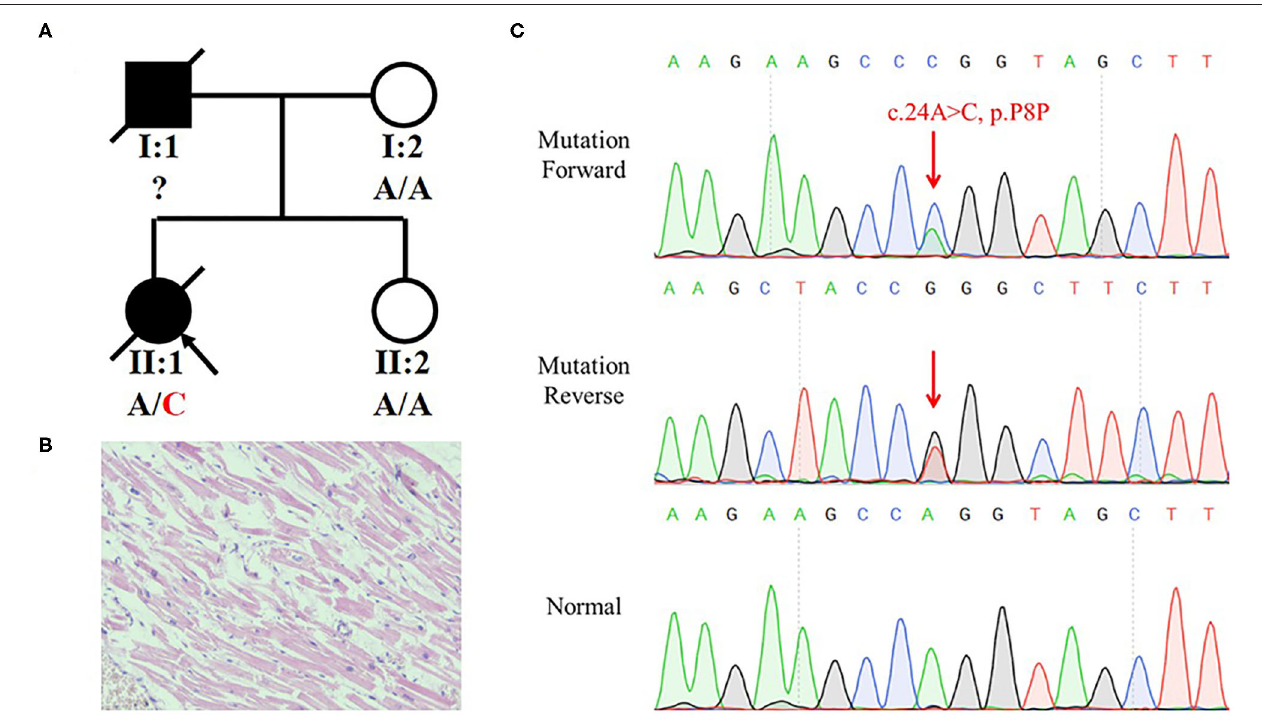
FIGURE 1 | Identification of a synonymous variant of MYBPC3 in a family with history of Sudden Cardiac Death (SCD). (A) Pedigree of the family with SCD. The black symbols represent the affected members and arrows indicate probands. Genotypes are identified by letters and a slash, with red representing variants. (B) H and E staining of left ventricle tissue of II:1 did not present hypertrophies and other anomalies. (C) Sequencing result of the MYBPC3 variant (c.24A > C, p.P8P) using Sanger sequencing. Red arrow indicates the variant